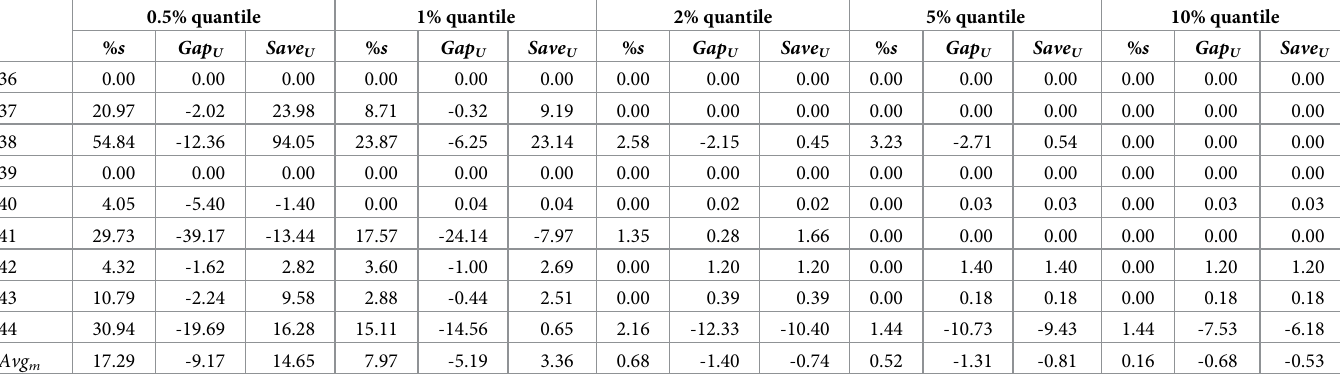
Table 5. Computational results for medium-size instances with different values of λ .